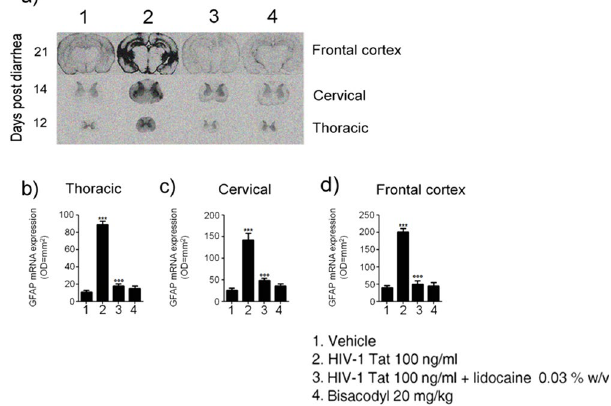
Figure 4. ( a ) In situ hybridization analysis of thoracic and cercival spinal cord, and frontal cortex showing GFAP mRNA expression at day 12, 14 and 21 after diarrhea induction, respectively. ( b – d ) Quantitative analysis revealed that administration of HIV-1 Tat protein caused a significant increase of GFAP mRNA expression in all the analyzed areas compared, as compared to both vehicle or lidocaine group, while bisacodyl yields to no significant change. (Results are expressed as mean ± SEM; *** p < 0.001 vs all other groups; °°°p < 0.001 vs HIV-1 Tat group; OD = optical density in mm 2 ; n = 5 for each